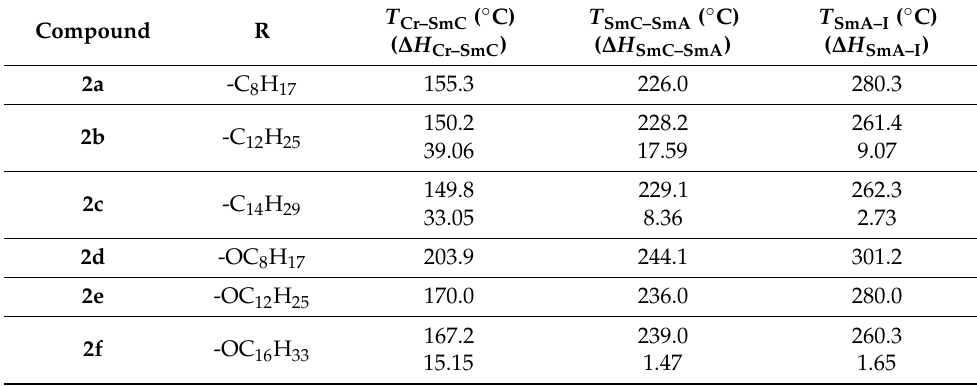
Table 3. Transition temperature ( ◦ C), associated (enthalpy of transitions in kJ g − 1 ).